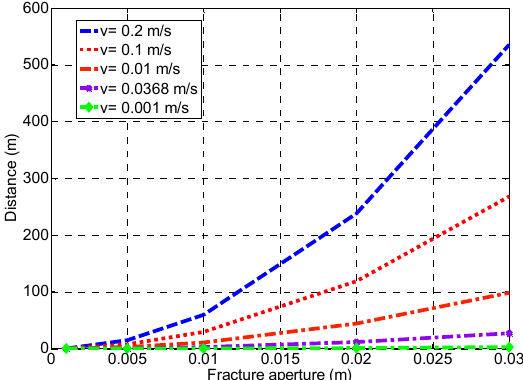
Figure 7. Sensitivity of travel distance and fracture aperture required to reach the target brine temperature of 90 °C (assuming fracture surface temperature fixed at 100 °C) for various brine velocities.